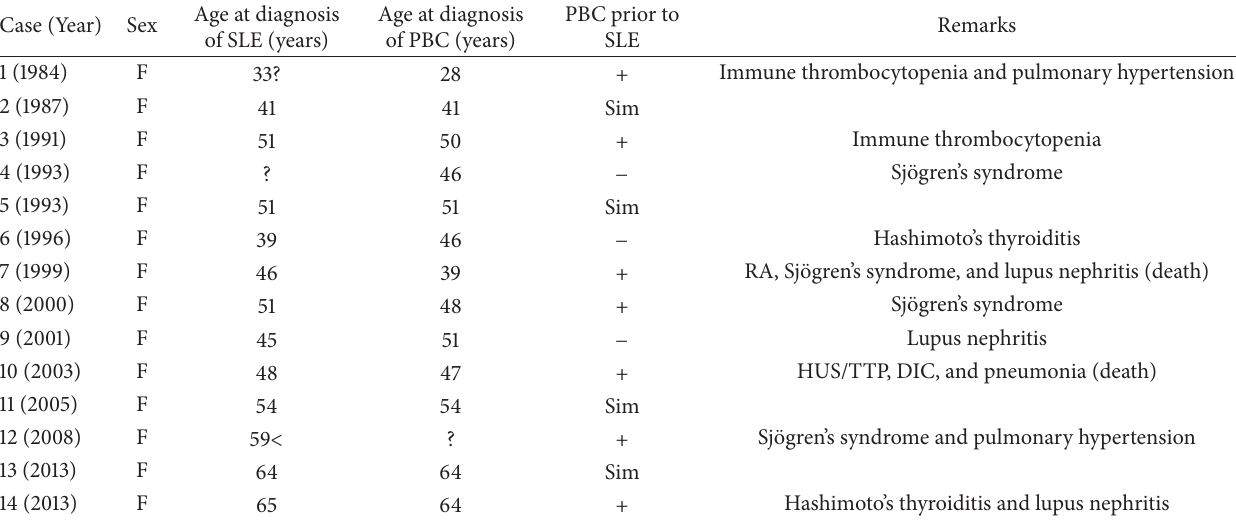
Table 2: Characteristics of 14 systemic lupus erythematosus patients with concomitant primary biliary cirrhosis derived from Japanese